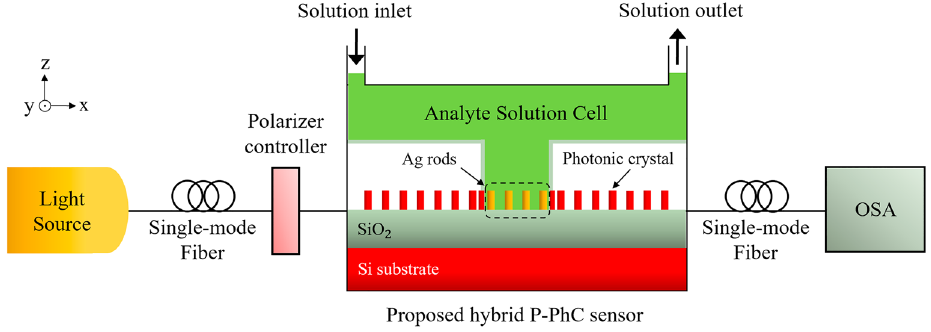
Figure 5. The schematic of the experimental setup used for the proposed hybrid P-PhC RI